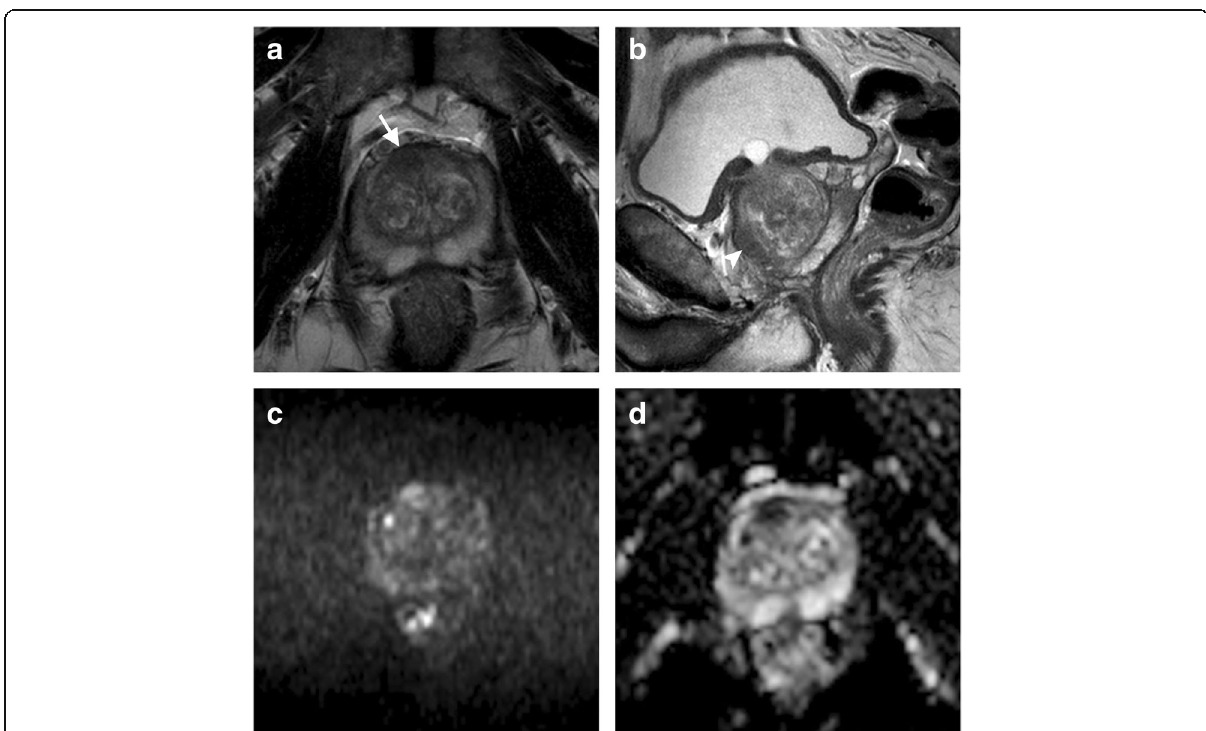
Fig. 2 Use of PI-RADS version 2 criteria to categorise a transition zone (TZ) finding in a 67-year-old patient with elevated PSA (7.80 ng/mL) and previous negative biopsies. On transverse (arrow in a ) and sagittal (arrowhead in b ) T2-weighted images, there was an anterior, right-sided TZ focal area with lenticular shape, ill-defined margins, and capsular bulging (< 15 mm in size), close to the anterior fibromuscular stroma. This finding was scored as PI-RADS 4 and confirmed to be a Gleason score 6 (3 + 3) cancer on biopsy and subsequent radical prostatectomy (T2b N0). DWI supported the suspicion of malignancy by showing restricted diffusion as corresponding, focal hyperintensity on b = 2000 s/mm 2 image ( c ) and marked hypointensity on the ADC map ( d )